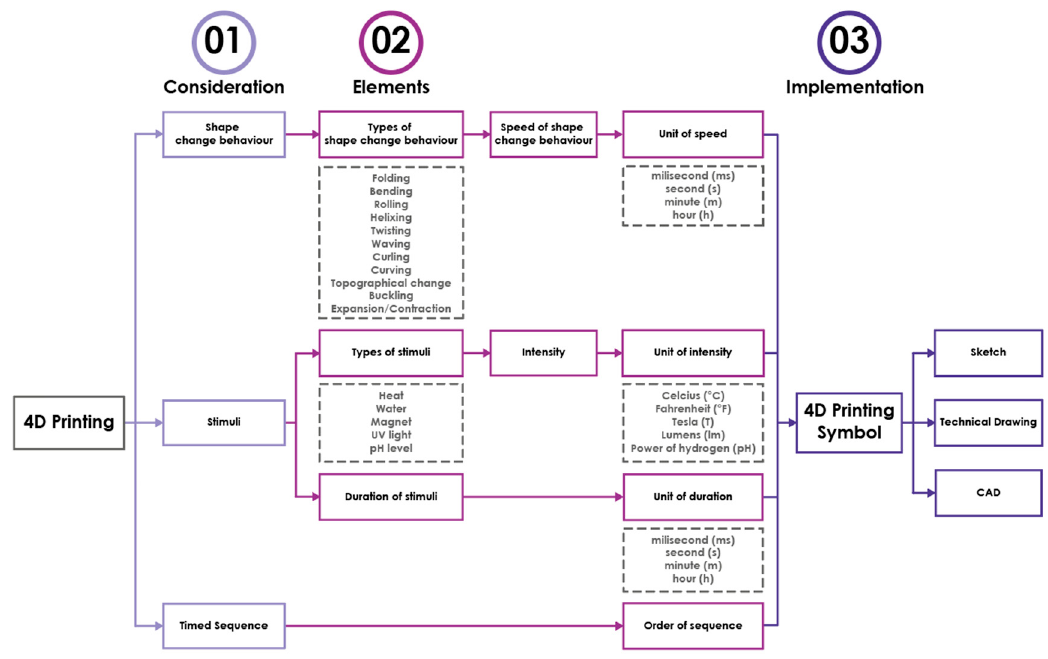
Figure 11. The conceptual framework for the 4D Printing symbol, created by the authors as per related literature.